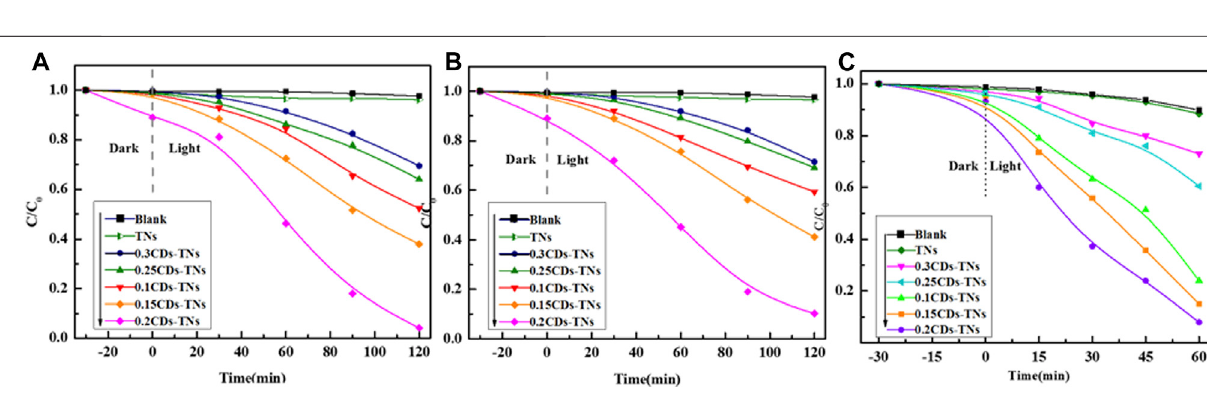
Frontiers in Chemistry |